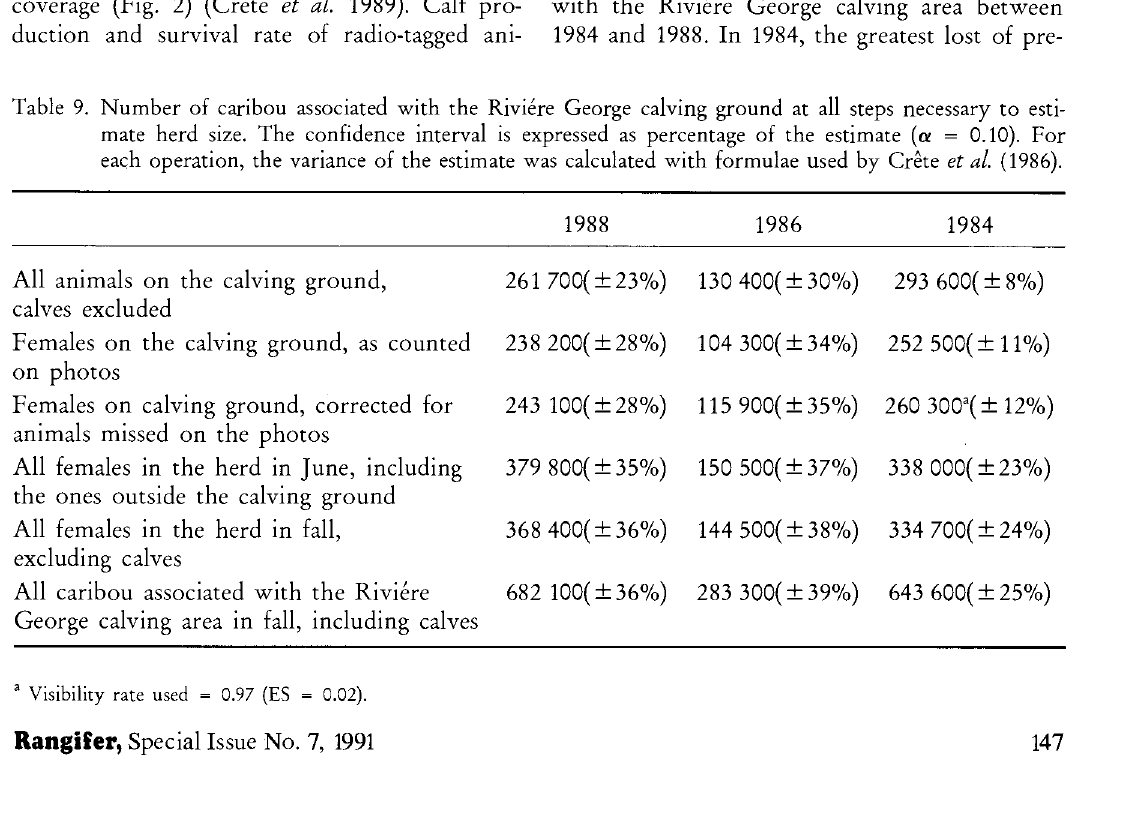
Table 9. Number of caribou associated with the Riviere George calving ground at all steps necessary to esti mate herd size. The confidence interval is expressed as percentage of the estimate (a = 0.10). For each operation, the variance of the estimate was calculated with formulae used by Crete et al.